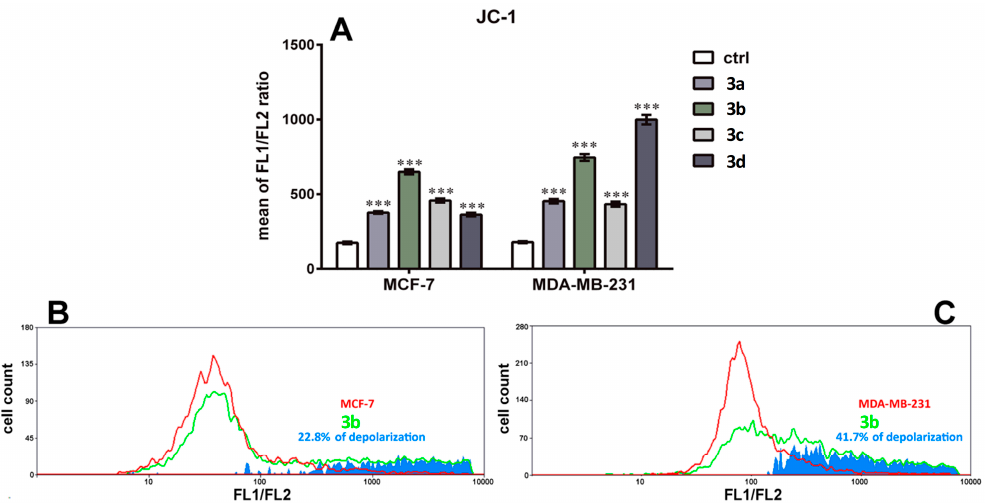
Figure 4. Hybrid-protoflavones induce mitochondrial membrane depolarization. ( A ) Increase in the ratio of green to red fluorescence (FL1 / FL2) assessed by JC-1 staining in MCF-7 and MDA-MB-231 cells after 24 h treatments with 1 µ M of compounds 3a – d ; ( B ) Illustration of the e ff ect induced by 3b in MCF-7 cells; ( C ) Illustration of the e ff ect induced by 3b in MDA-MB-231